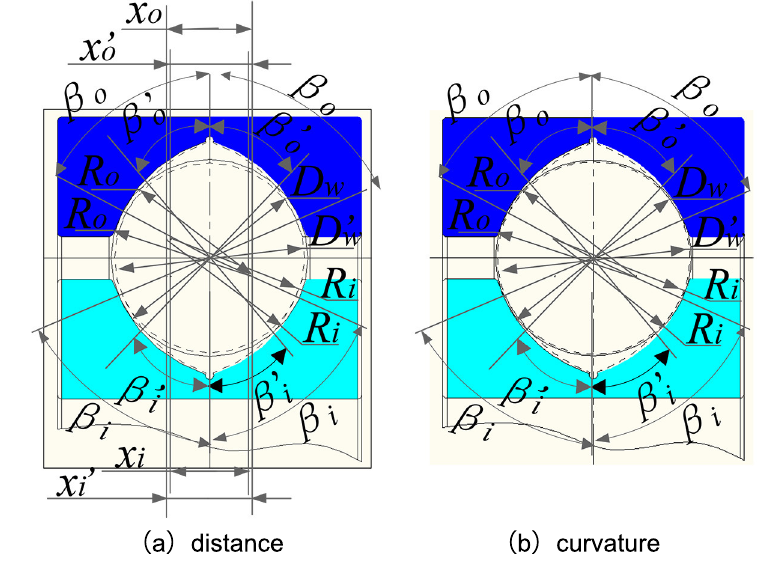
Fig. 3 contact angle variation owing to